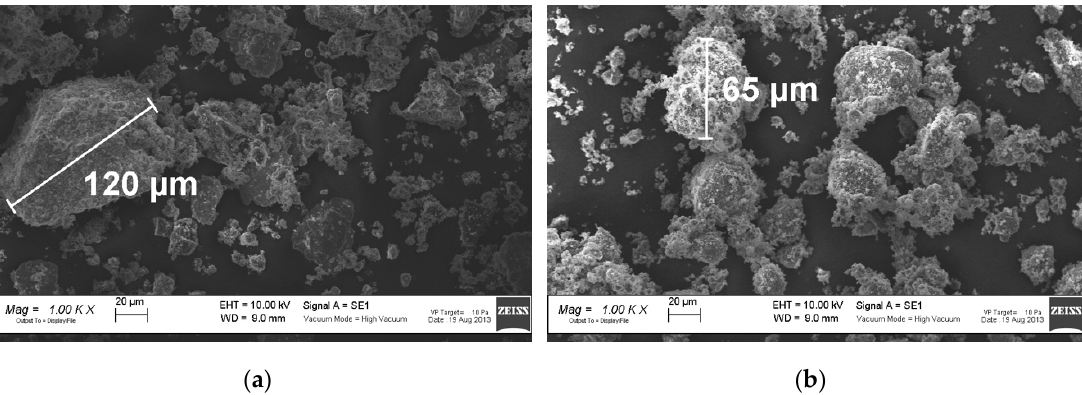
Figure A3. SEM image of 2 LiH + MgB 2 + 0.025 TiCl 3 : ( a ) an unmilled sample and ( b ) a sample milled at 330 rpm for 30 h with 50% of filling and a BPR of 5:1.